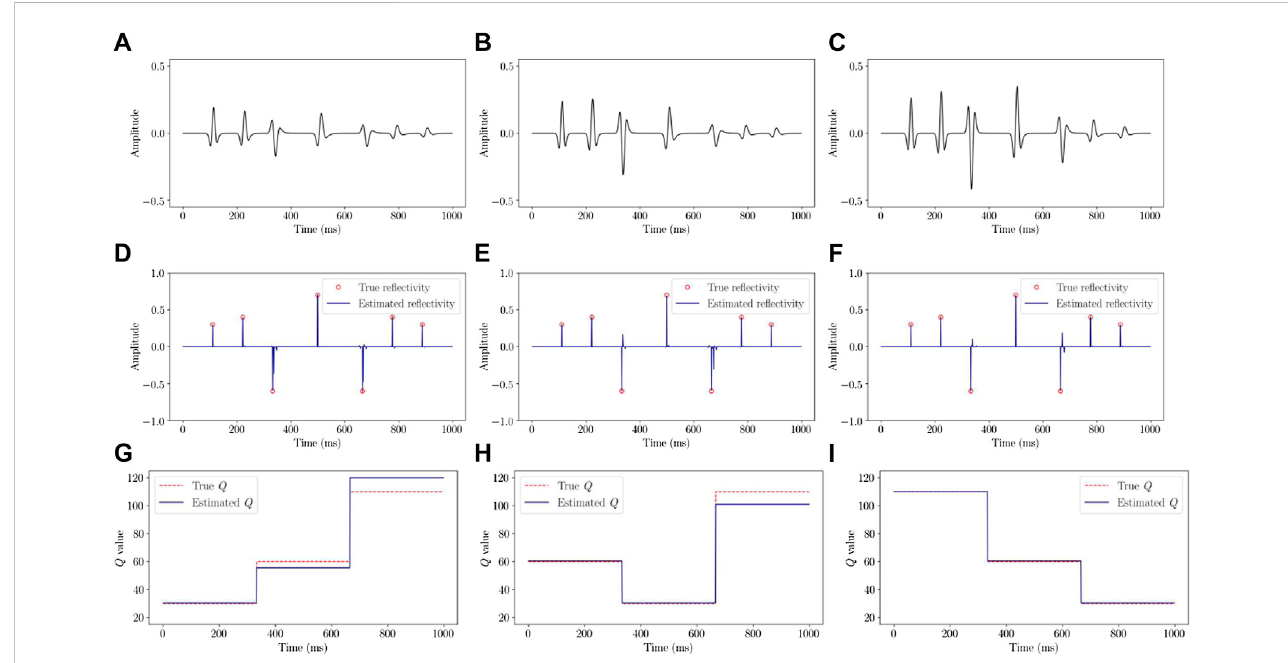
FIGURE 5 Simple synthetictracesattenuated byusinginterval- Q modelwith different Q values: (A) Q = (30,60,110), (B) Q = (60,30,110), and (C) Q =(110,60, 30). Theestimatedre fl ectivityseriesare shownin (D – F) .Thetrue non-zerore fl ectivitycoef fi cients areshownbytheredpoints. Thecorresponding estimationsof the Q values are showed in (G – I) . The true Q values are shown in red lines.